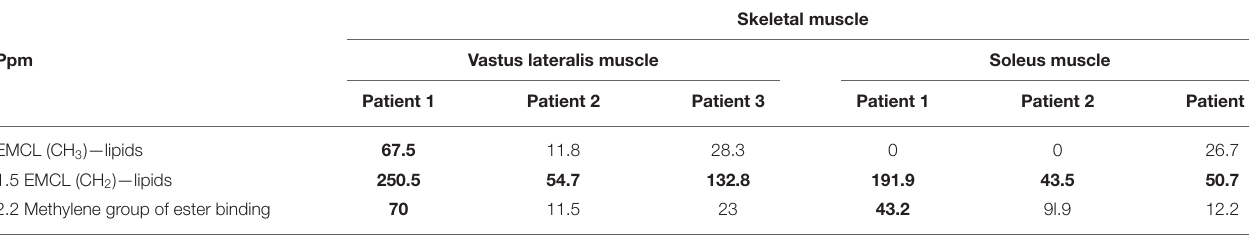
TABLE 2 | Lipid amplitude in MR spectroscopy (MRS) in vastus lateralis muscle and soleus muscle. Skeletal muscle Ppm Vastus lateralis muscle Soleus muscle Patient 1 Patient 2 Patient 3 Patient